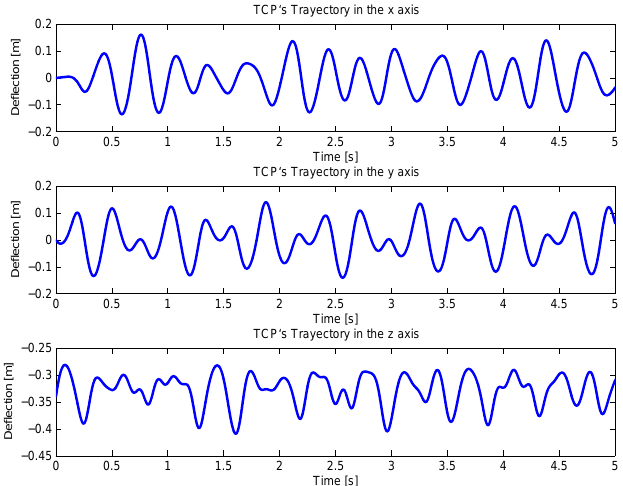
Figure 8. The reference trajectory of the TCP for the defined movement of the